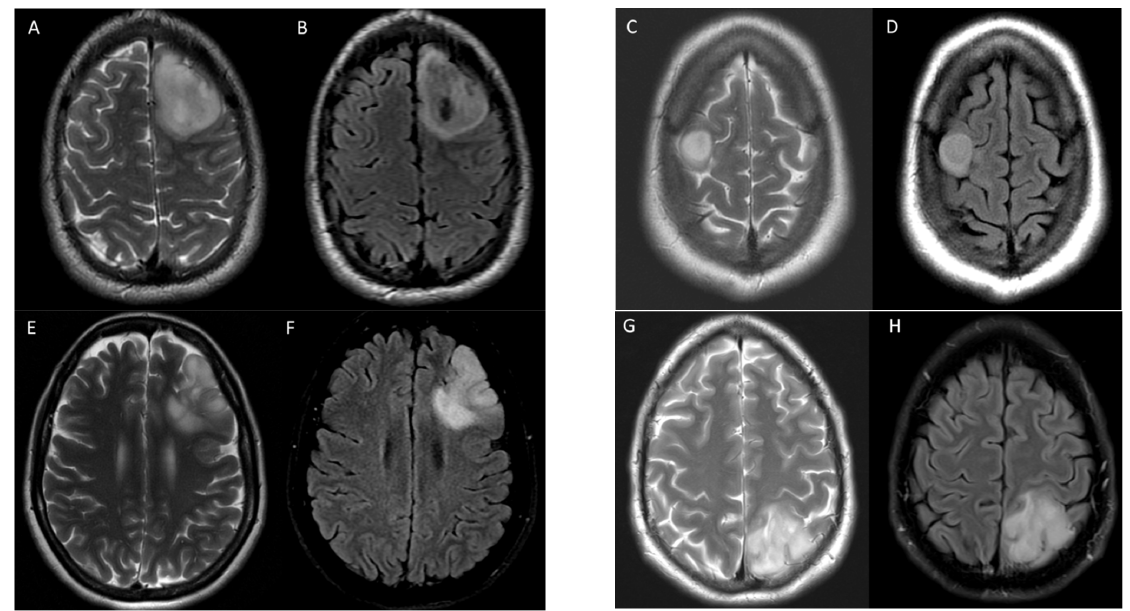
Figure 2. Examples of T2-FLAIR match and mismatch in 4 patients with IDH1 mutant